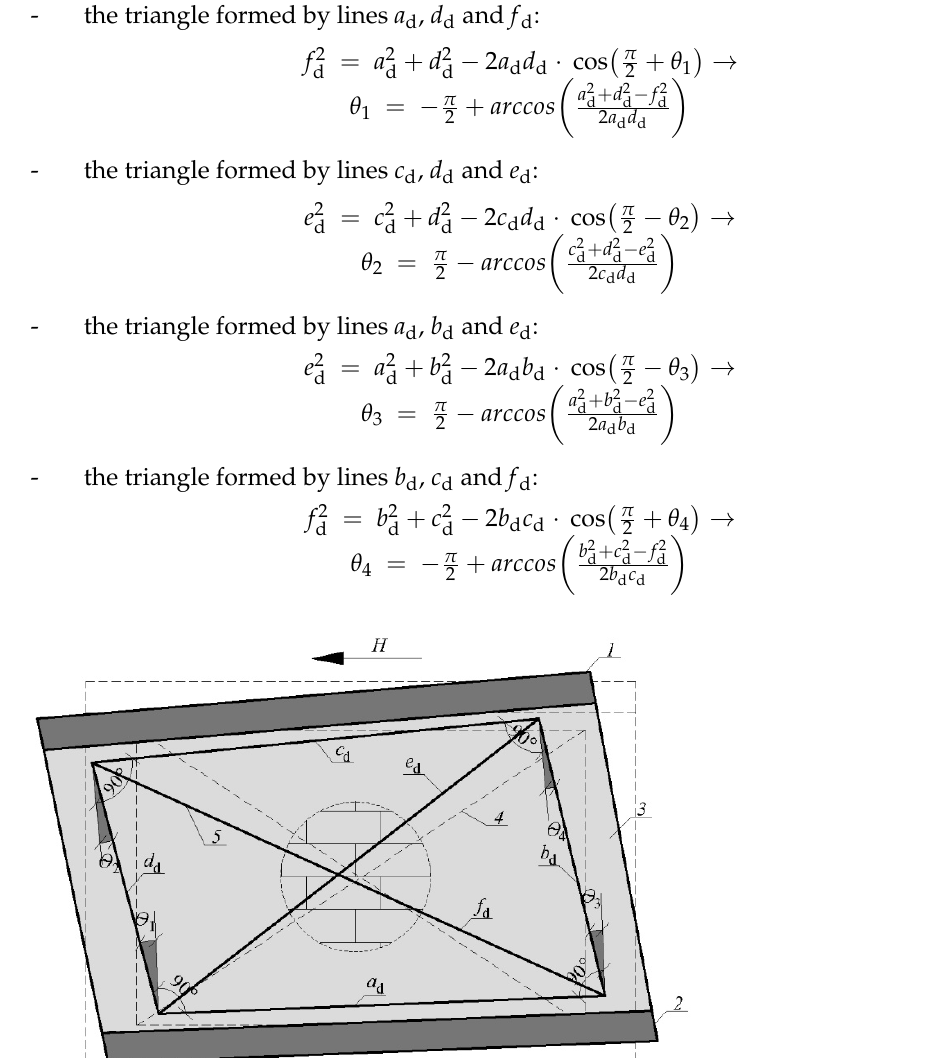
Figure 8. Deformation of measuring base (frame system) due to the action of shear force; H —horizontal shear force; 1 —rigid diaphragm; 2 —concrete foundation; 3 —masonry wall made of AAC; 4 —measuring base before deformation; 5 —measuring base after deformation; a d , c d —deformed horizontal part of the frame system; b d , d d —deformed vertical part of the frame system; e d , f d —deformed diagonal part of the frame